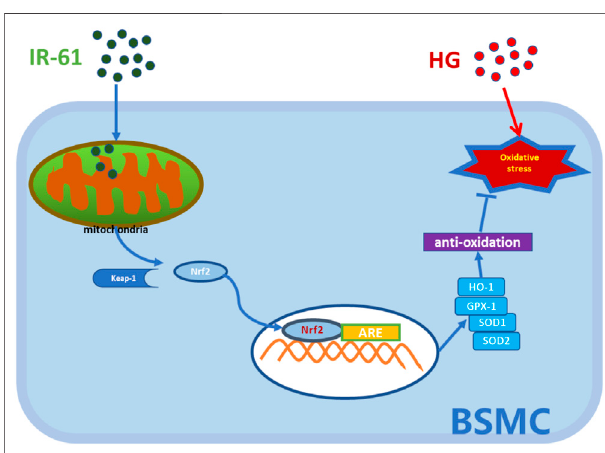
FIGURE 7 | Illustration of the working hypothesis of the potential mechanism. The pre-administered IR-61 slightly elevates intracellular ROS level, which accelerates the dissociation of Nrf2 from Kelch-like ECH- associated protein-1 (Keap-1) into the nucleus via activating Nrf2 pathways. Increased Nrf2 nucleolus translocation elicits robust antioxidants, such as HO-1, SOD, and GPX-1, and then protects bladder smooth muscle cells (BSMCs) from oxidative stress damage induced by hyperglycemia, thereby preventing or slowing down the occurrence of bladder smooth muscle cells